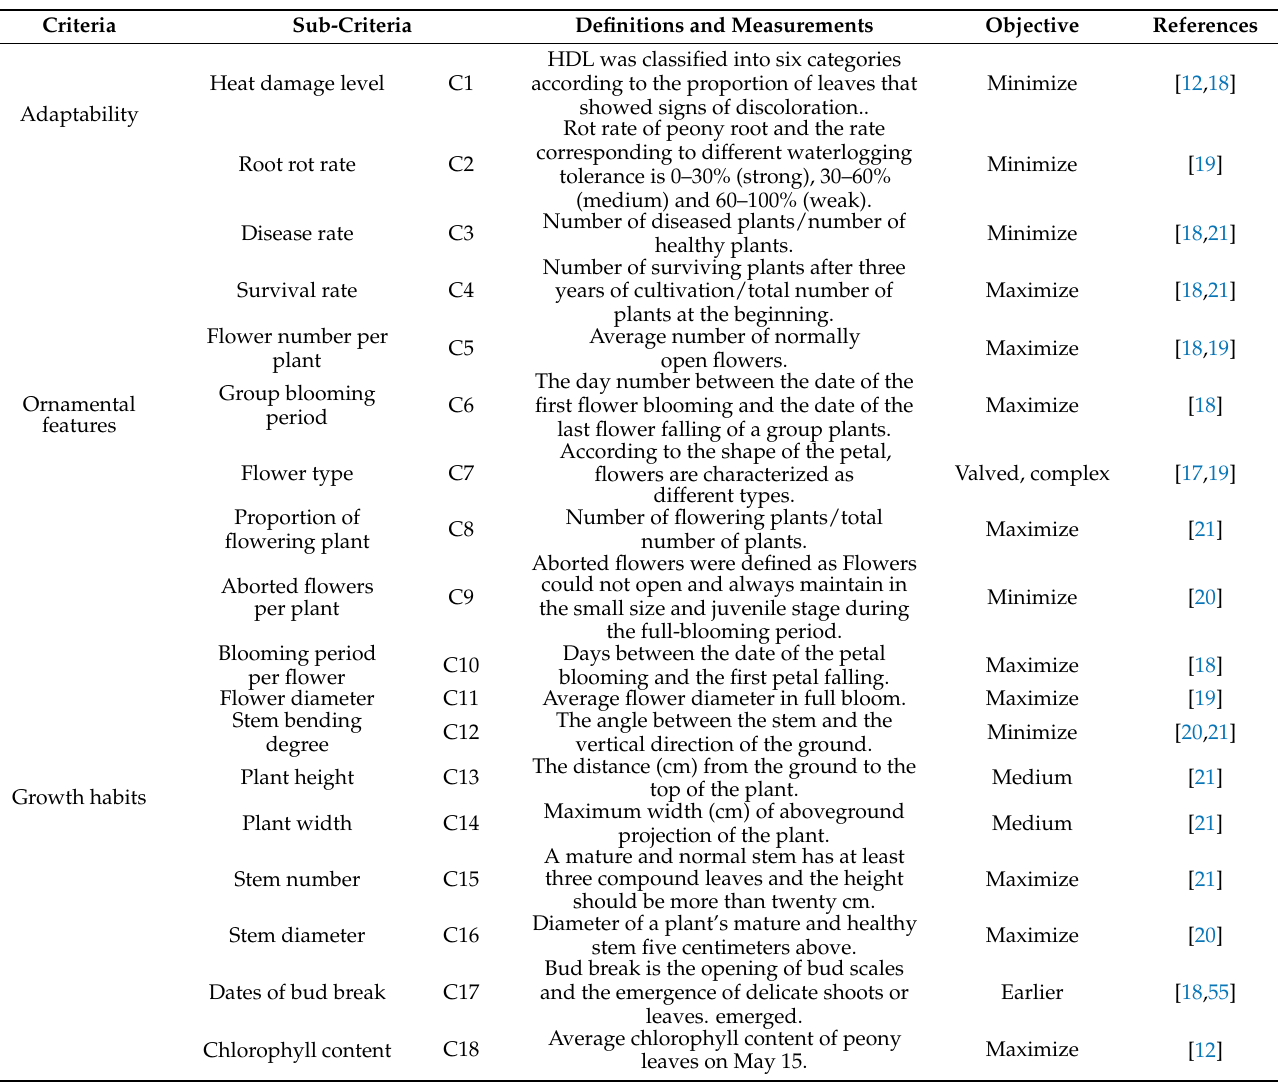
Table 4. Details of evaluation indices and